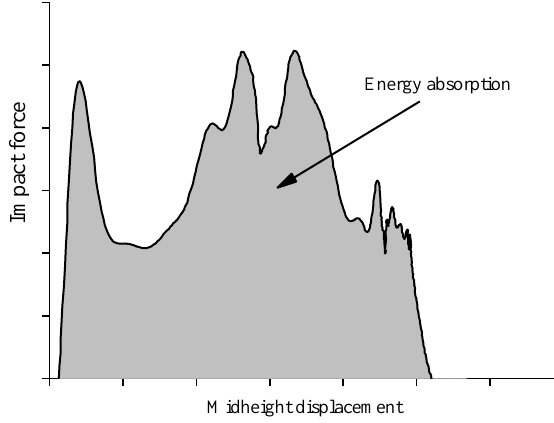
Figure 10. Calculation of the energy absorption.